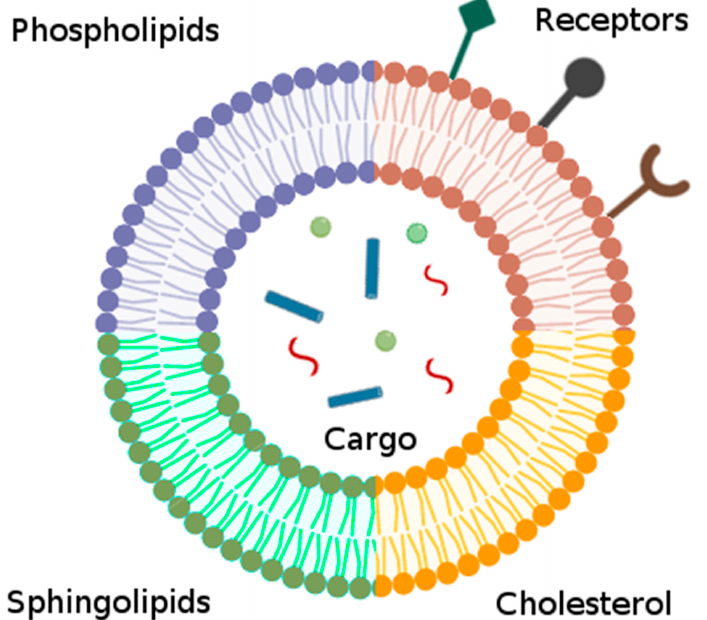
Figure 3. Extracellular vesicle (EV)-mimicking liposomes can be engineered to mimic EV features by recreating the lipidomic profile (e.g., phospholipids, sphingolipids, cholesterol), and by conjugating proteins and receptors to recreate the targeting specificity. The liposomes can also be loaded with a variety of molecules, including proteins, siRNAs, miRNAs and small molecules, to recapitulate common EV